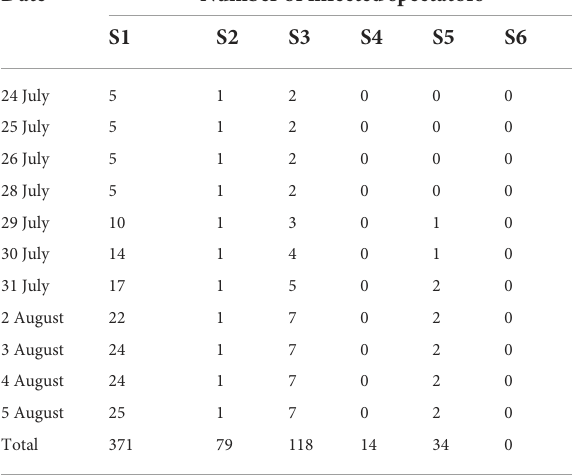
TABLE 4 Number of infected audiences during 2021 CLS game